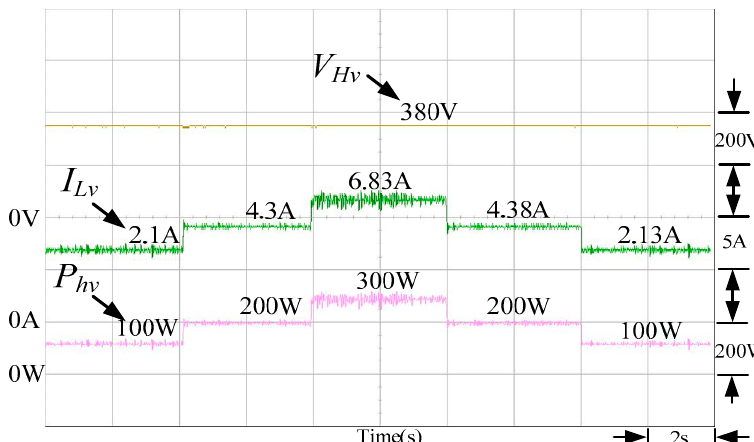
Figure 15. Measured results of the load power changed from 100 to 300 W and then lowered to 100 W.